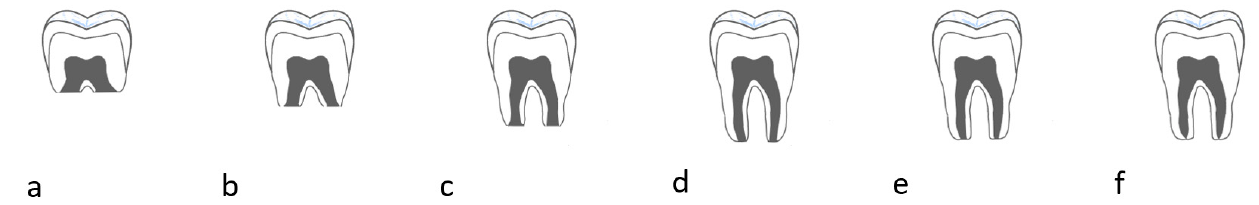
Figure 3. Stages of development of the root of a molar according to Moorrees CFA et al. (1963) [62]: ( a ). stage 1: roots developed to one-quarter of their length; ( b ). stage 2: roots developed to one-half of their length; ( c ). stage 3: roots developed to three-quarters of their length; ( d ). stage 4: roots developed along their entire length with open apices; ( e ). stage 5: root apices half closed by a wide periodontal ligament; ( f ). stage 6: roots with closed apices.